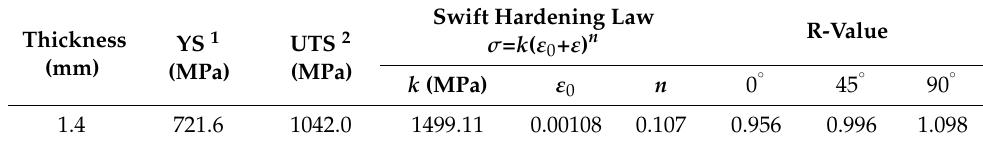
Table 1. Mechanical properties of a DP980 steel sheet obtained from the tensile test.